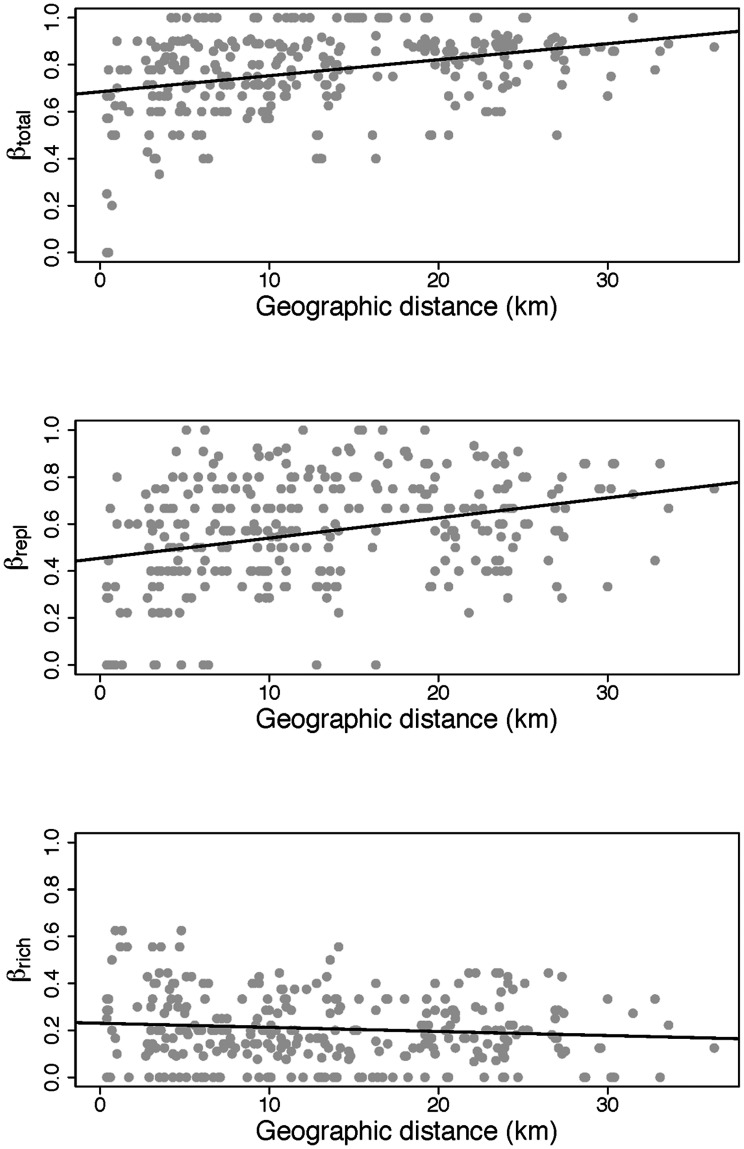
Distance decay in ground beetle assemblages’ dissimilarity.Distance dissimilarity plots representing the relationship between ground beetle assemblage dissimilarity and geographic distance. βtotal, βrepl and βrich were used as measures of overall beta diversity, beta diversity due to species replacement and beta diversity due to richness differences, respectively.